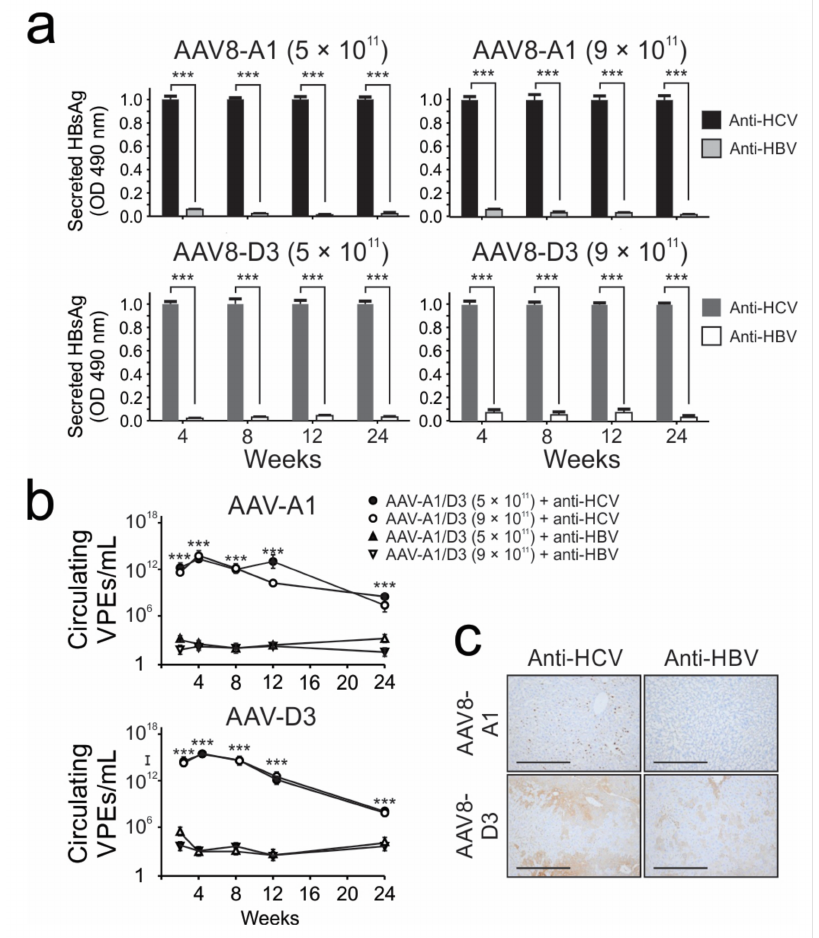
Figure 6. Inhibition of HBV gene expression and replication in mice treated with AAVs carrying HBV genomes and HBV-targeting artificial micro RNAs. ( a ), serum HBsAg and ( b ), HBV VPEs post- injection of mice with saline or co-transduction with AAV8-HBV and artificial primary microRNA (apri-miR)-expressing vectors. Values represent the means and SEMs calculated from data obtained from 4 mice per group. Statistically significant differences between the samples were